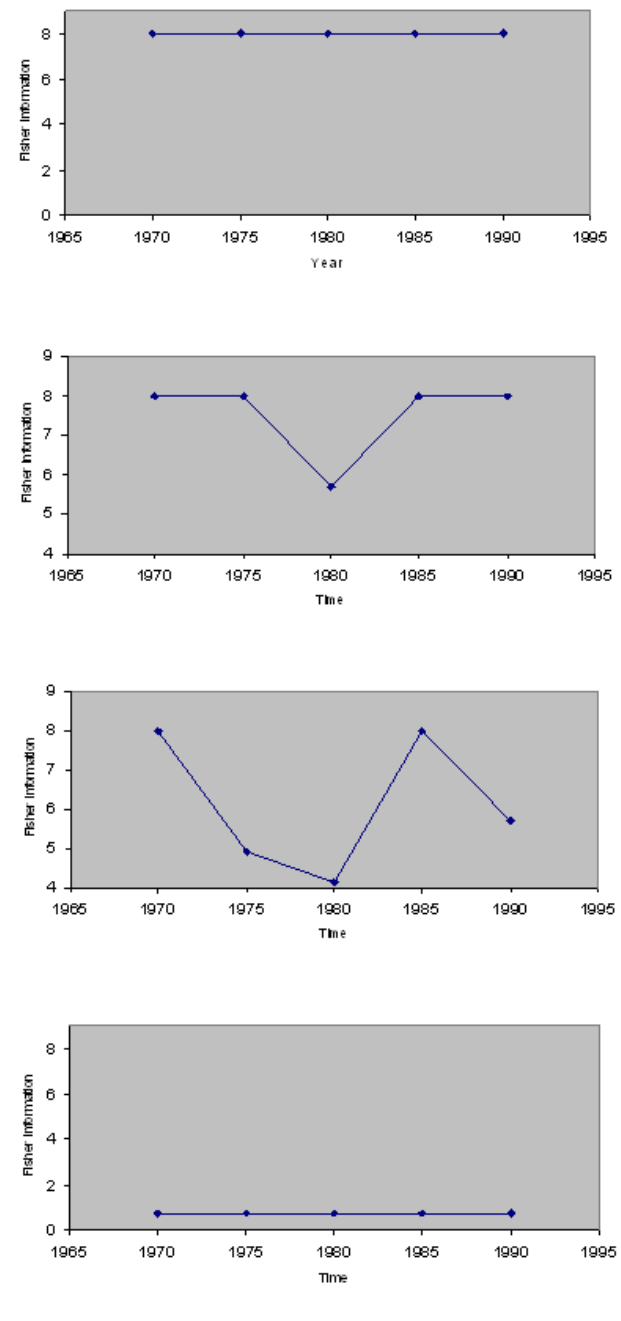
Fig. 6. Fisher information: different tightening levels (TL) a) TL: 40%, b) TL: 50% c), TL: 60%, d) TL: 100